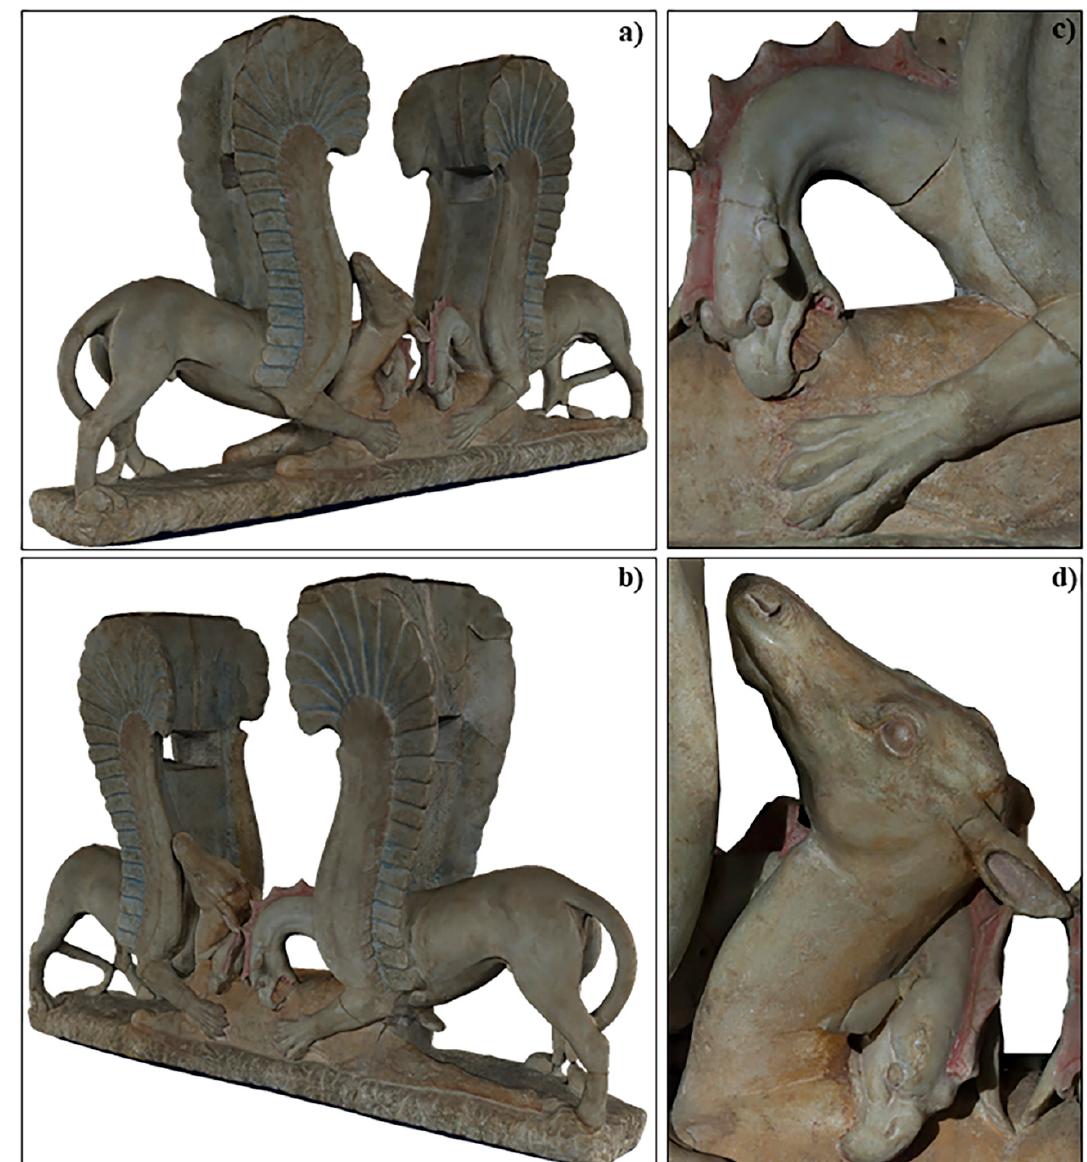
Figure 3. High-resolution 3D model: front ( a ) and back view ( b ) and two details of the sculpture ( c , d ). Then, a bandpass filter and background removal were respectively applied to reduce noise